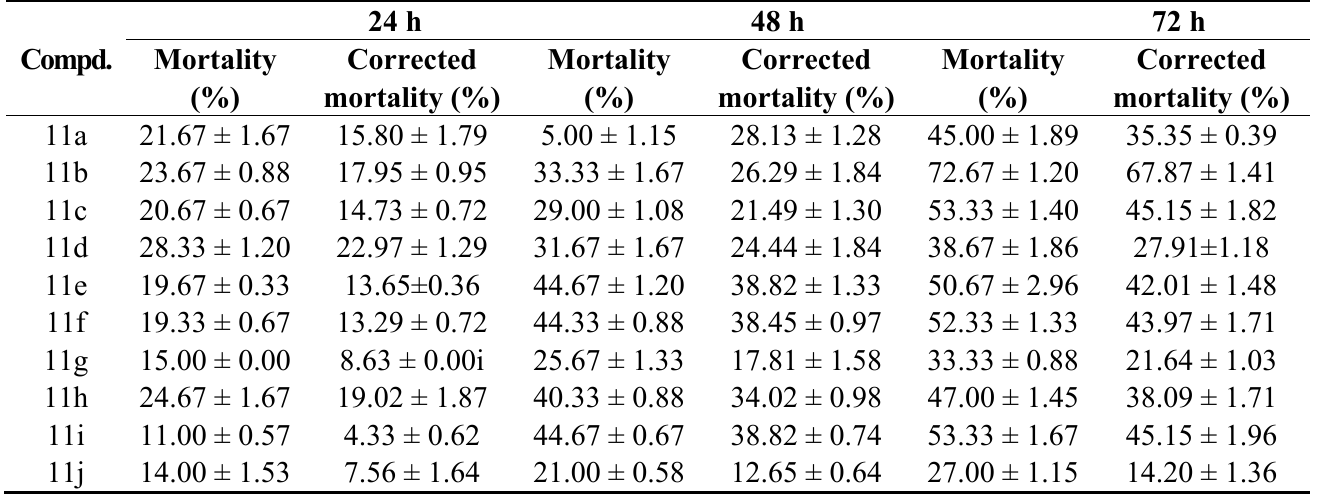
Table 3. Nematicidal Activity of the title